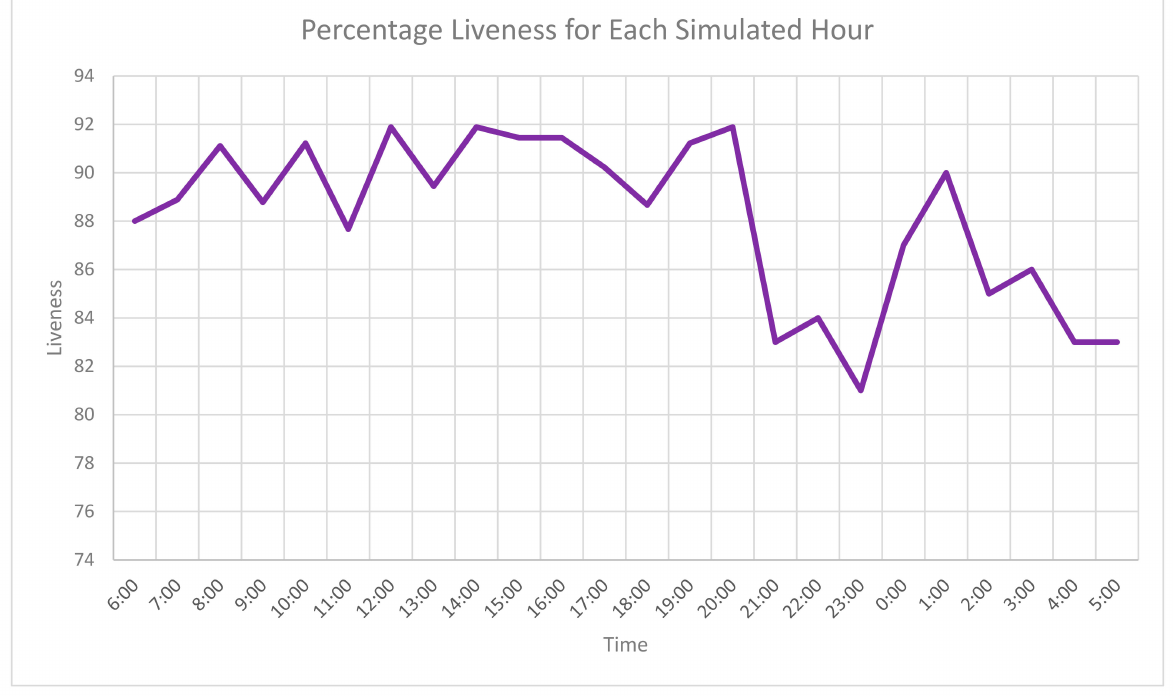
Figure 11. Percentage of liveness for each simulated hour, averaged over 20